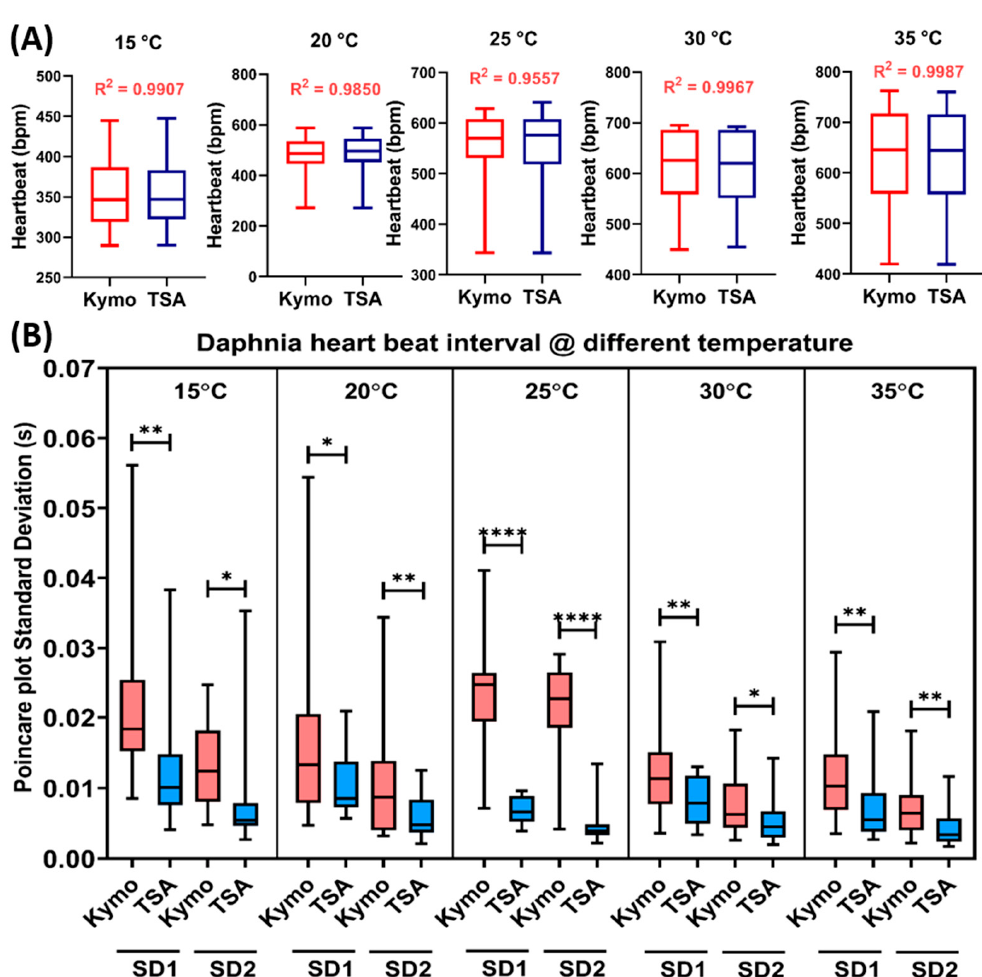
Figure 4. Comparison of kymograph (kymo) and time serial analyzer (TSA) methods on analyzing heart rate variability in Daphnia magna neonates cultured at different ambient temperatures. Two important indexes of standard deviation 1 (SD1) and standard deviation 2 (SD2) in the Poincare plot are used to measure heart rate regularity. Data were normalized for Pearson correlation calculation ( A ) and Wilcoxon test ( B ), and presented as mean ± SEM ( n = 20). (* p < 0.5, ** p < 0.1, **** p < 0.0001, n = 20).